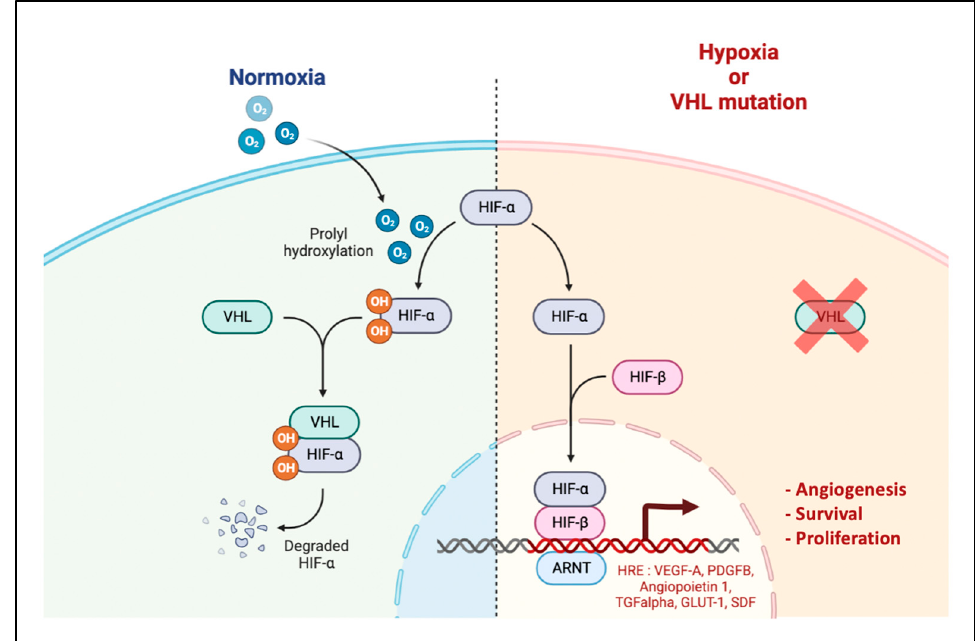
Figure 2. HIF Pathway. Under normoxic conditions, HIF- α is hydroxylated by prolyl hydroxylases (PHD) and then recognized by the VHL protein. Once VHL is bound to HIF- α , this leads to its ubiquitination and degradation by the proteasome. Under hypoxic conditions, HIF- α is not hydrox- ylized, accumulates in the cytosol, translocates to the nucleus and heterodimerizes with its subunit HIF- β . This leads to the transcription of genes with a hypoxia responsive element (HRE) in their promoter, responsible for cellular adaptation to hypoxia such as angiogenesis, survival, glucose metabolism and proliferation. Adapted from “HIF signalling”, by BioRender.com (2022).